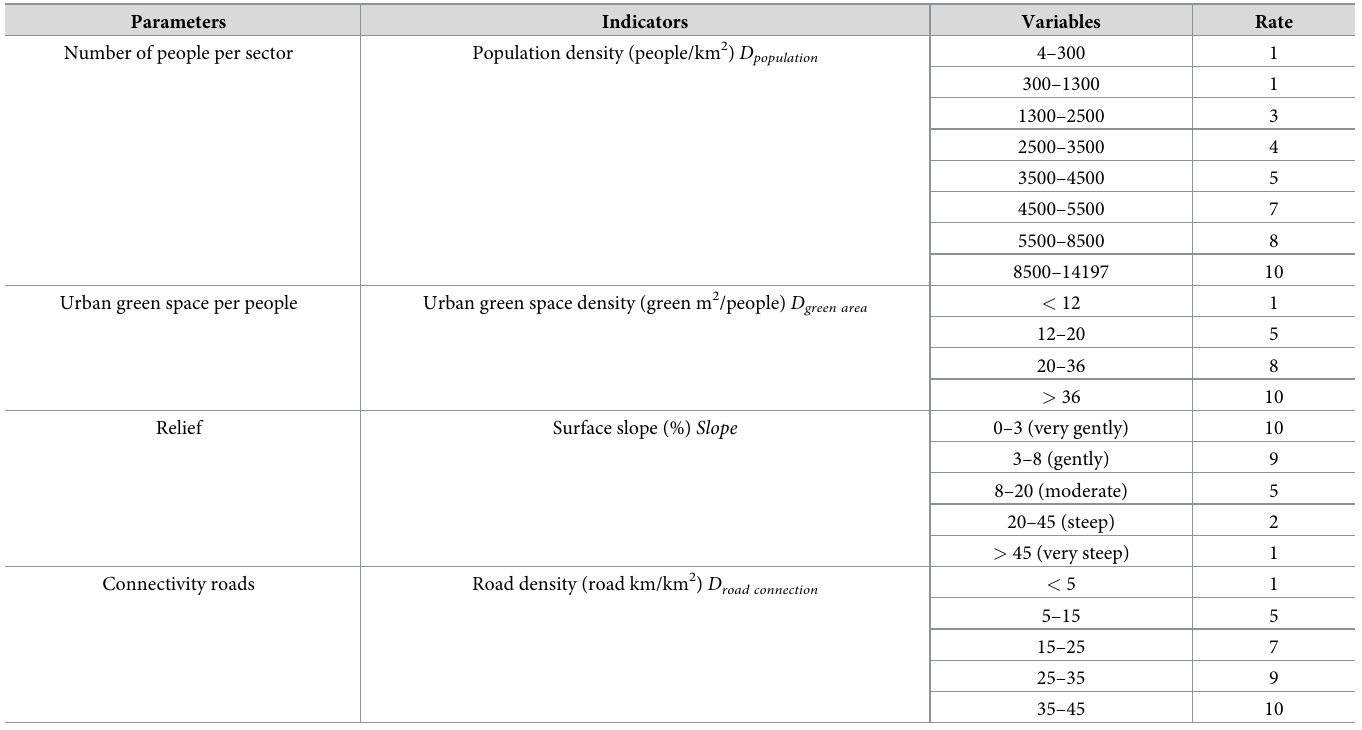
Table 1. Criteria for urban pattern